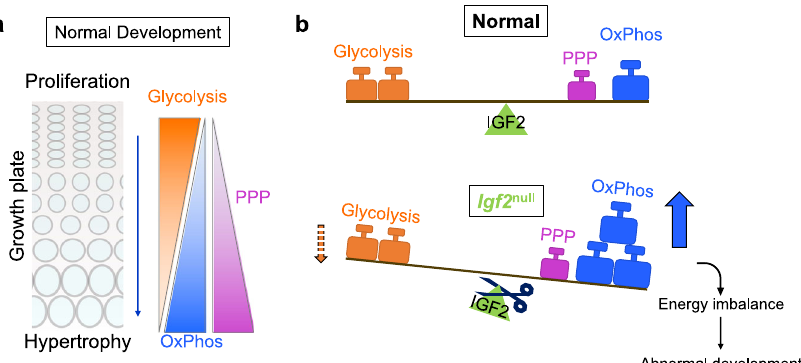
Fig. 8 A working model of the metabolic switch in chondrocytes during hypertrophy. a As chondrocytes progress from a proliferating state to a hypertrophic state in the growth plate, they undergo a metabolic switch from a state of high glycolysis to a state of high oxidative phosphorylation and pentose phosphate pathway activity. b IGF2 balances the metabolic switch, such that when it is removed, hypertrophic Igf2 null chondrocytes experience heightened oxidative phosphorylation compared to WT